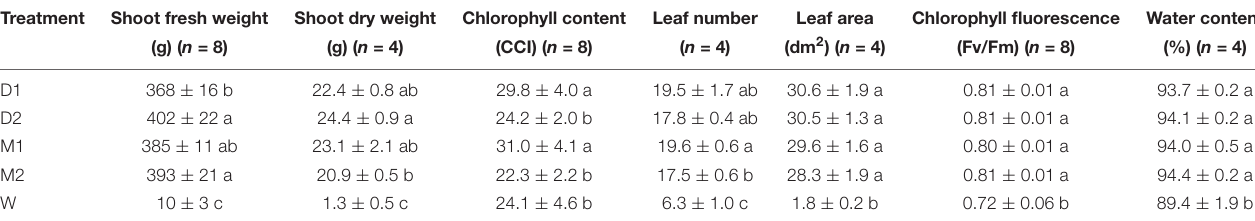
TABLE 3 | Growth and quality parameters at harvest of the pak choi grown in a soilless system fertilized with anaerobic digestate (D1, D2) or mineral nutrient solution (M1, M2).